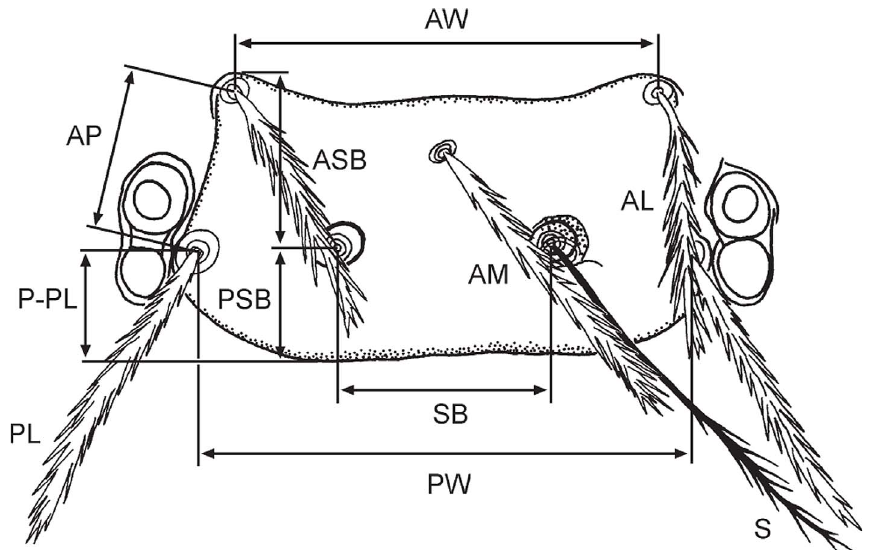
Figure 2. Scutum of chiggers and measurements (abbreviations and corresponding morphology are the same as in Table 2, cited from Stekolnikov, 2013